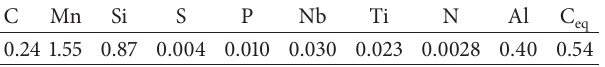
Table 1: Chemical composition of the investigated steel,